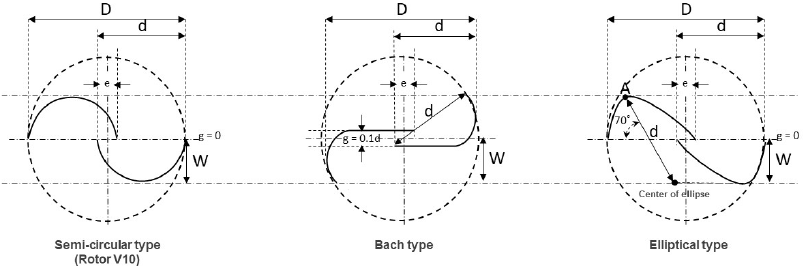
Figure 7. Bach and elliptical rotor design geometries according to semi ‐ circular geometry.